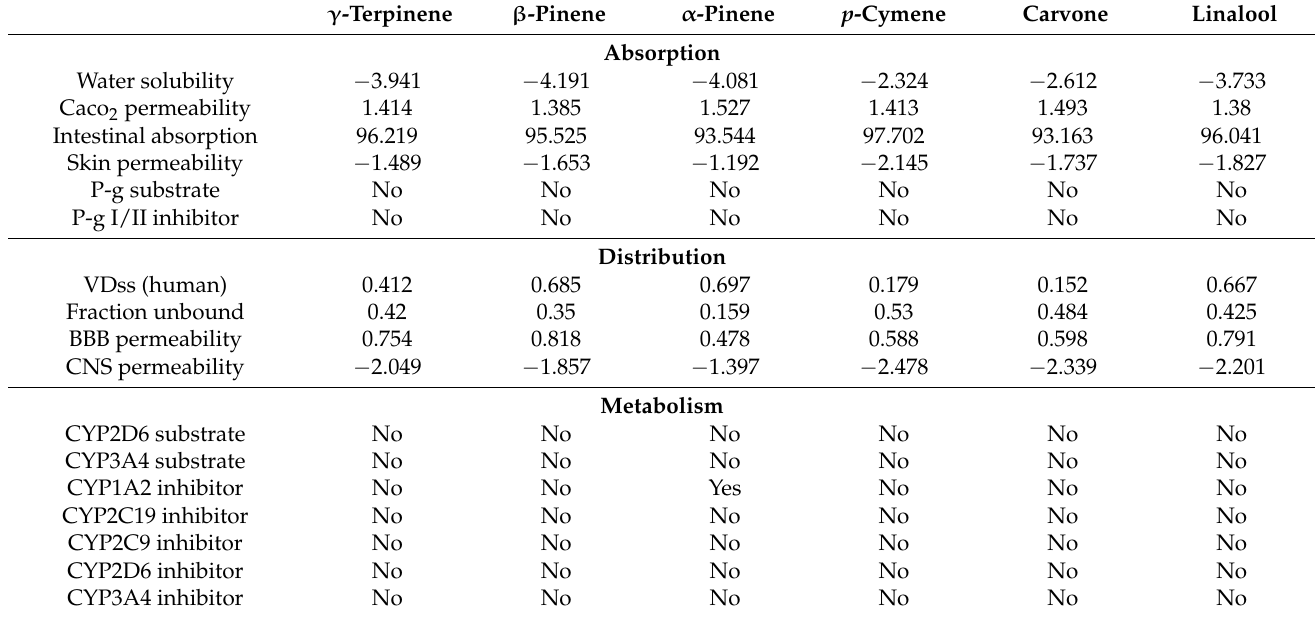
Table 8. Pharmacokinetics profiles of the major identified